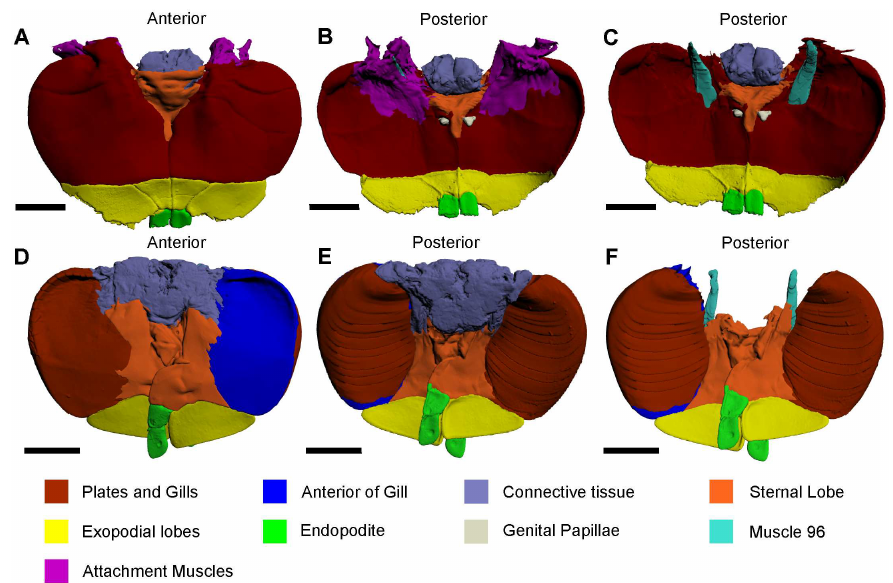
Fig 9. Anterior and posterior views of thoracetronic appendages, as modelled from iodine staining and micro-CT scanning. (A, B) Anterior and posterior views of the genital operculum. (D, E) Anterior and posterior views of a gill operculum. (C, F) Posterior views of the genital operculum and the gill operculum, respectively, with sections removed to depict muscle 96. The reconstructions in A–C were selected from the genital operculum 3D PDF (S7 Fig). The reconstructions in D–F were selected from the gill operculum 3D PDF (S8 Fig). All scale bars 20